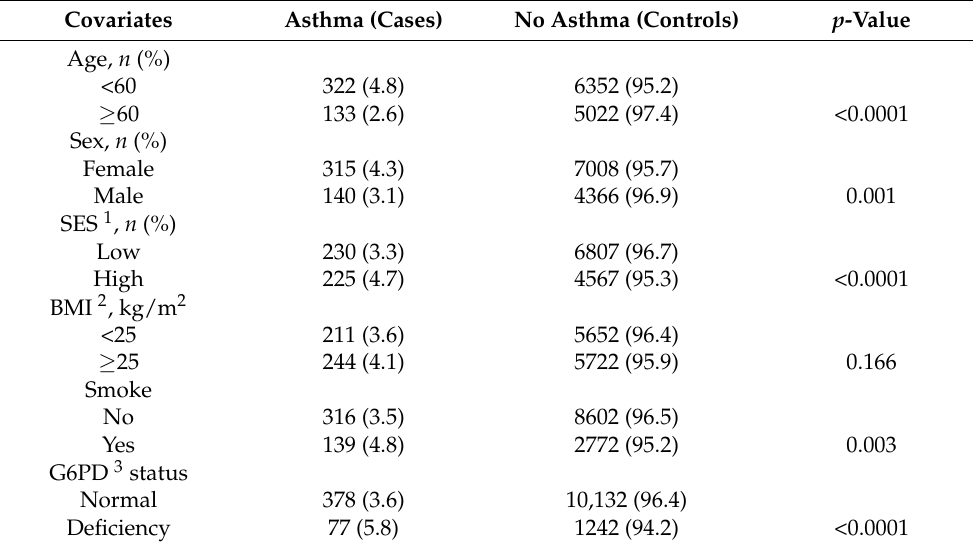
Table 1. Characteristics of 11,829 study participants with and without